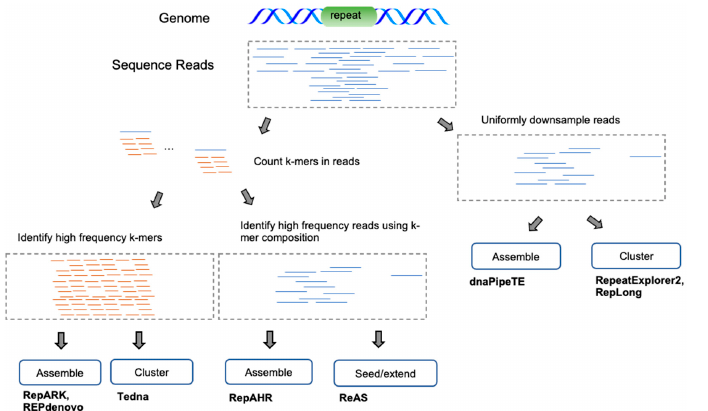
Figure 4. Read-based de novo methodologies. Due to the overwhelming size of read datasets, methods often start by either downsampling or filtering low-coverage regions based upon read k-mer frequencies. At this stage, either the remaining reads or the k-mers themselves are assembled into contigs or clustered into distinct groups representing repetitive families.